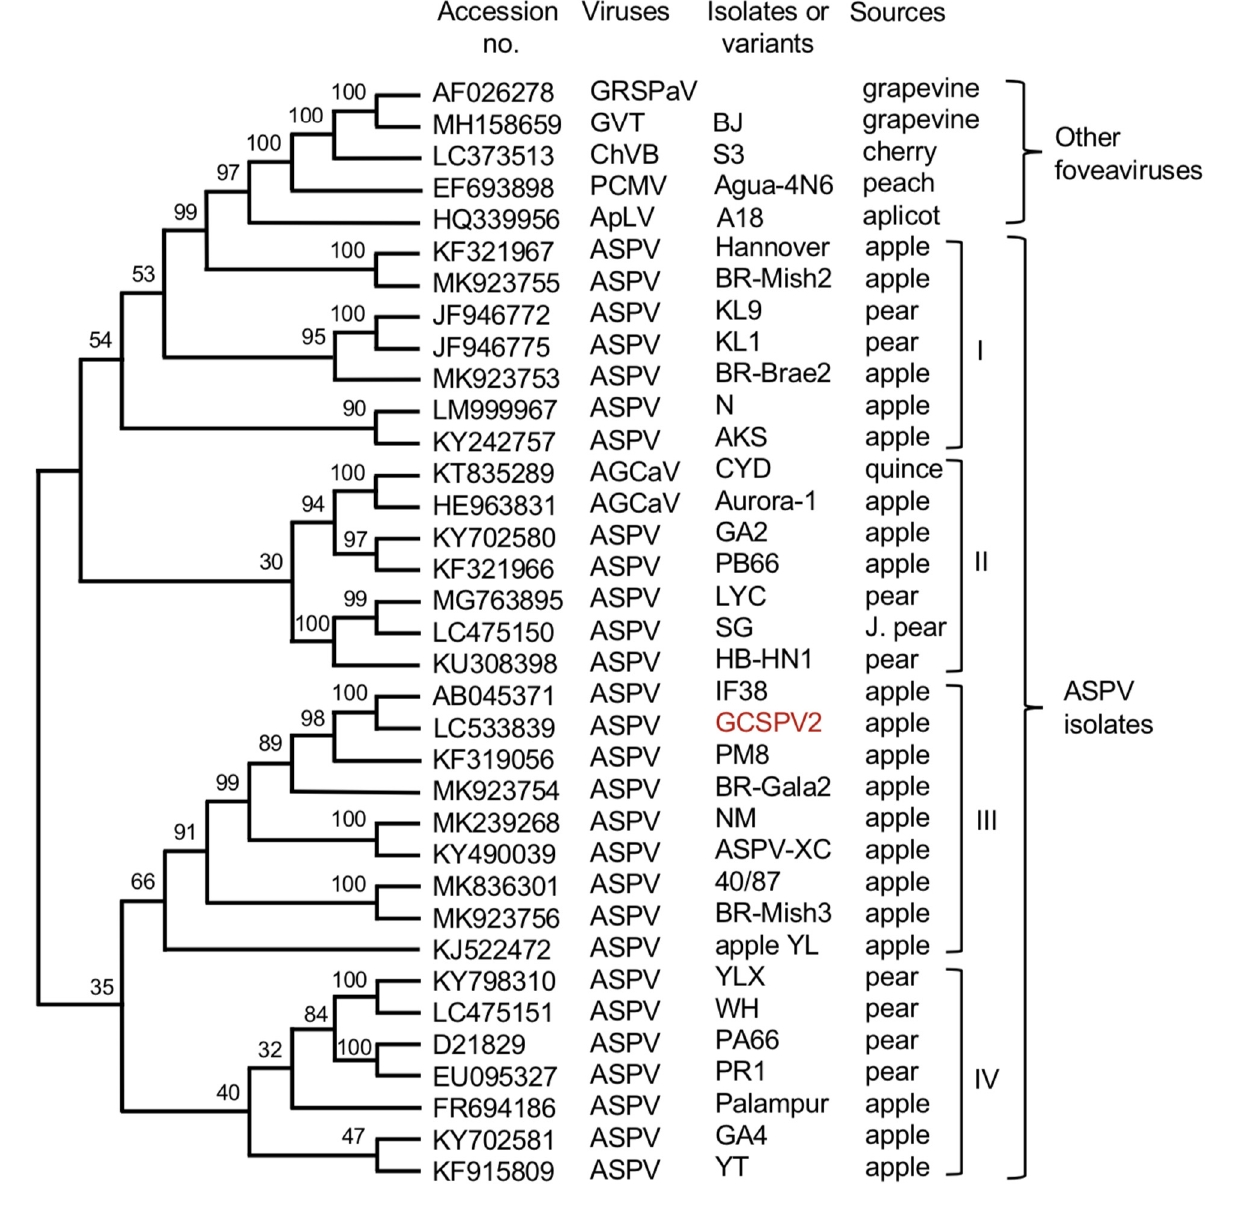
FIGURE 5 | Phylogenetic tree based on the complete nucleotide sequences of ASPV isolates, AGCaV isolates, and five other foveaviruses including grapevine rupestris stem pitting associated virus (GRSPaV), apricot latent virus (ApLV), grapevine virus T (GVT), peach chlorotic mottle virus (PCMV), and cherry virus B (ChVB). A sequence variant analyzed in this study is shown in red. The tree was generated by CLUSTALW program (DNA databank of JAPAN [DDBJ]; URL: http://clustalw.ddbj.nig.ac.jp/). Bootstrap values for each node are shown (1000